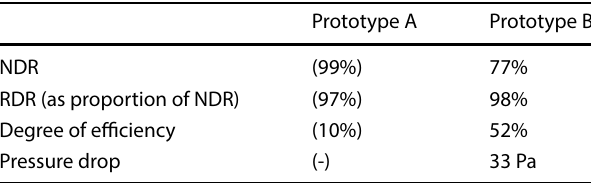
Coefficients for prototype B were calculated under different assumptions and cannot be readily compared, as is indicated by